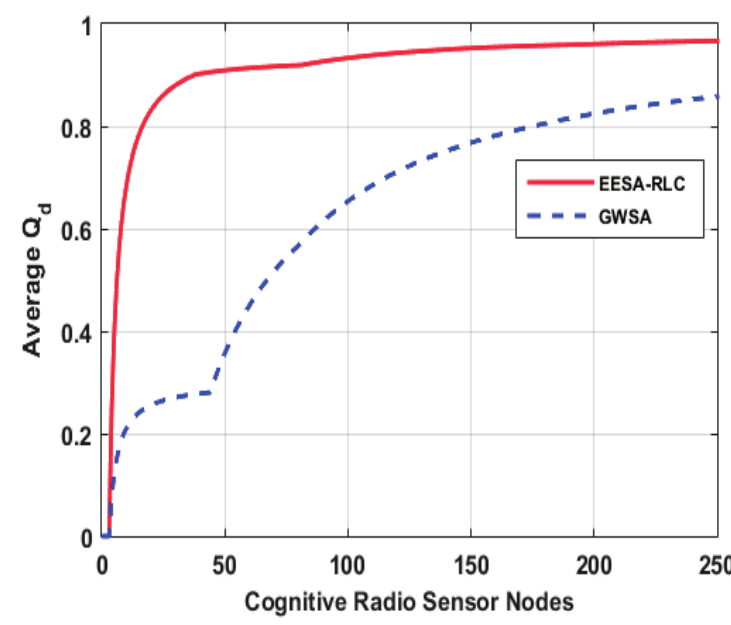
Figure 13. Average energy consumption for clusters.